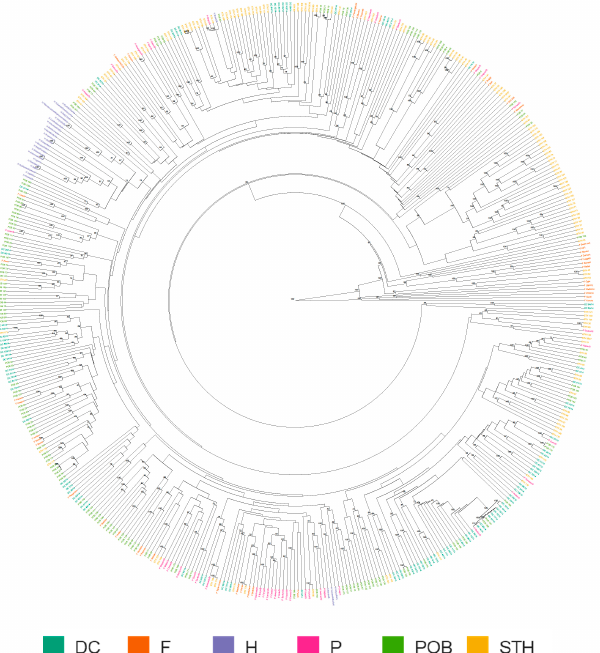
Figure 3. Hierarchical circular clustering dendrogram of 487 A. sativa genotypes based on 7411 SNPs generated using the UPGMA method and Provesti’s distance matrix with 1000 bootstraps. Different colors indicate different genotype groups: Historic cultivars (H), foreign cultivars (F), and breeding lines from the ongoing programs of breeding at Małopolska Plant Breeding Ltd. (POB), Strzelce Plant Breeding Ltd. (STH), and Danko Plant Breeding Ltd. (DC).